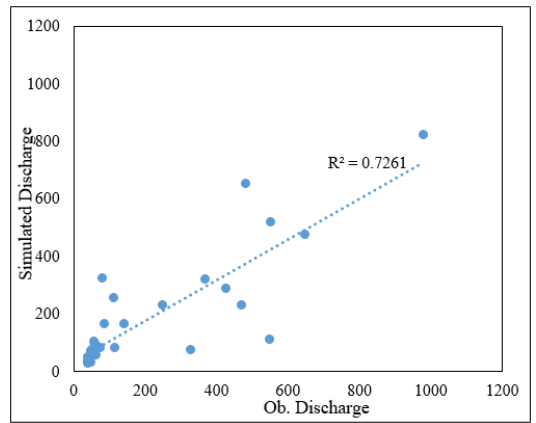
Figure 10 Scatter plot at Sujanpur outlet